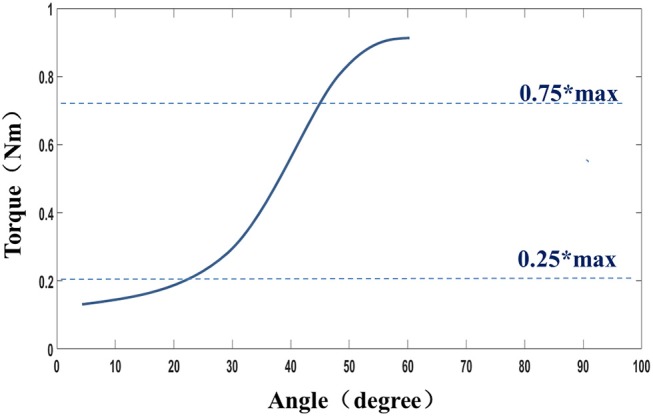
Definition of the stiffness.